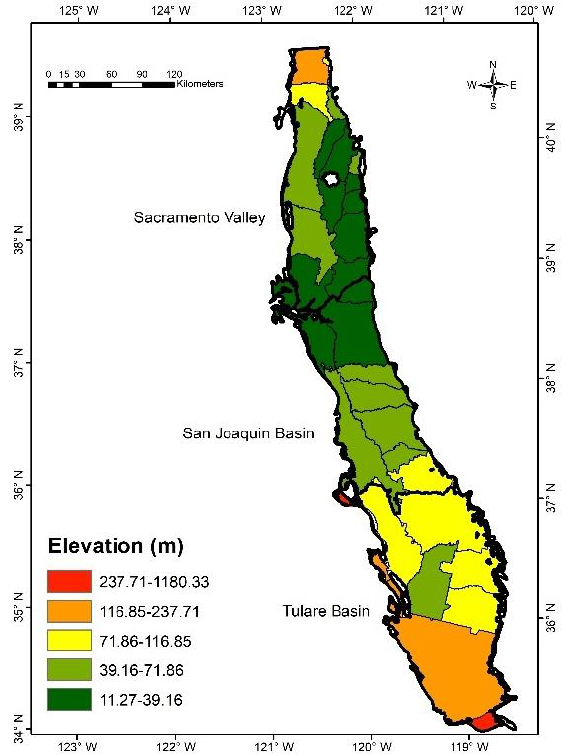
Figure 15. Elevation in Central Valley